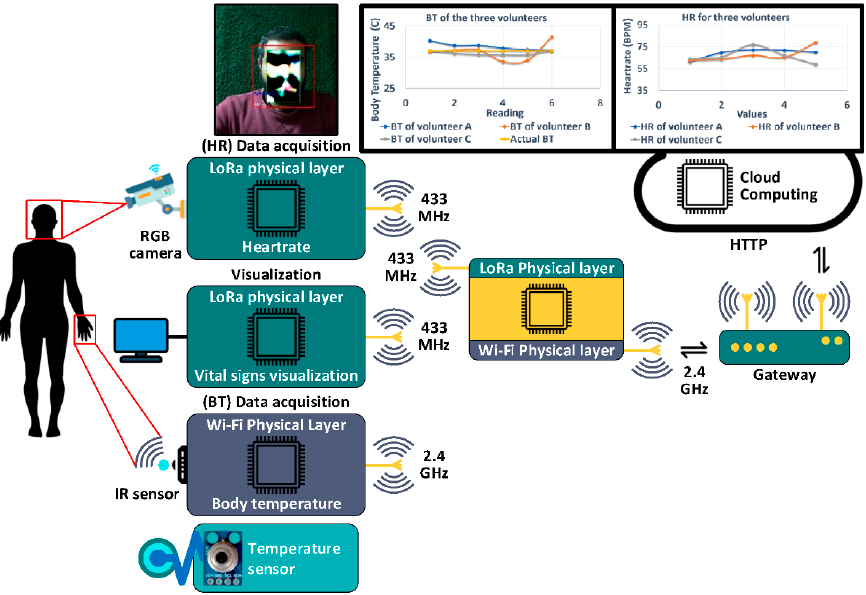
Figure 5. The architecture of IoT System for non-invasive vital data acquisition (modified from [30,39]).